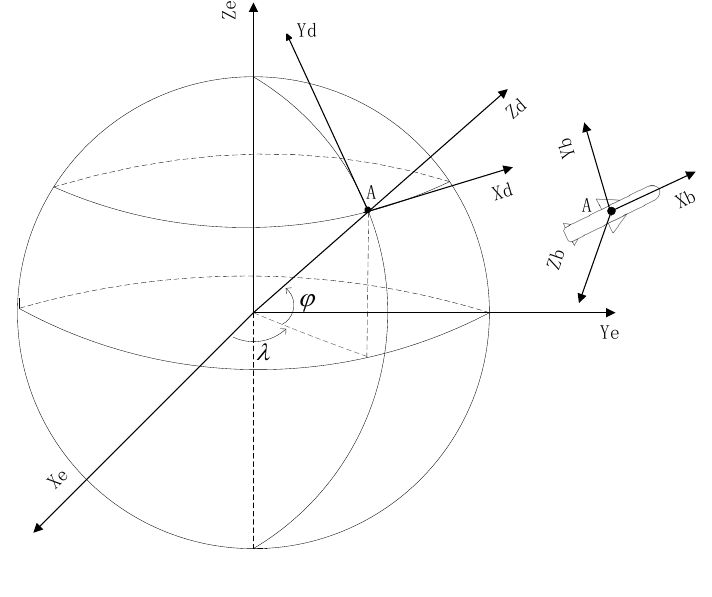
Figure 1. The definition of coordinate